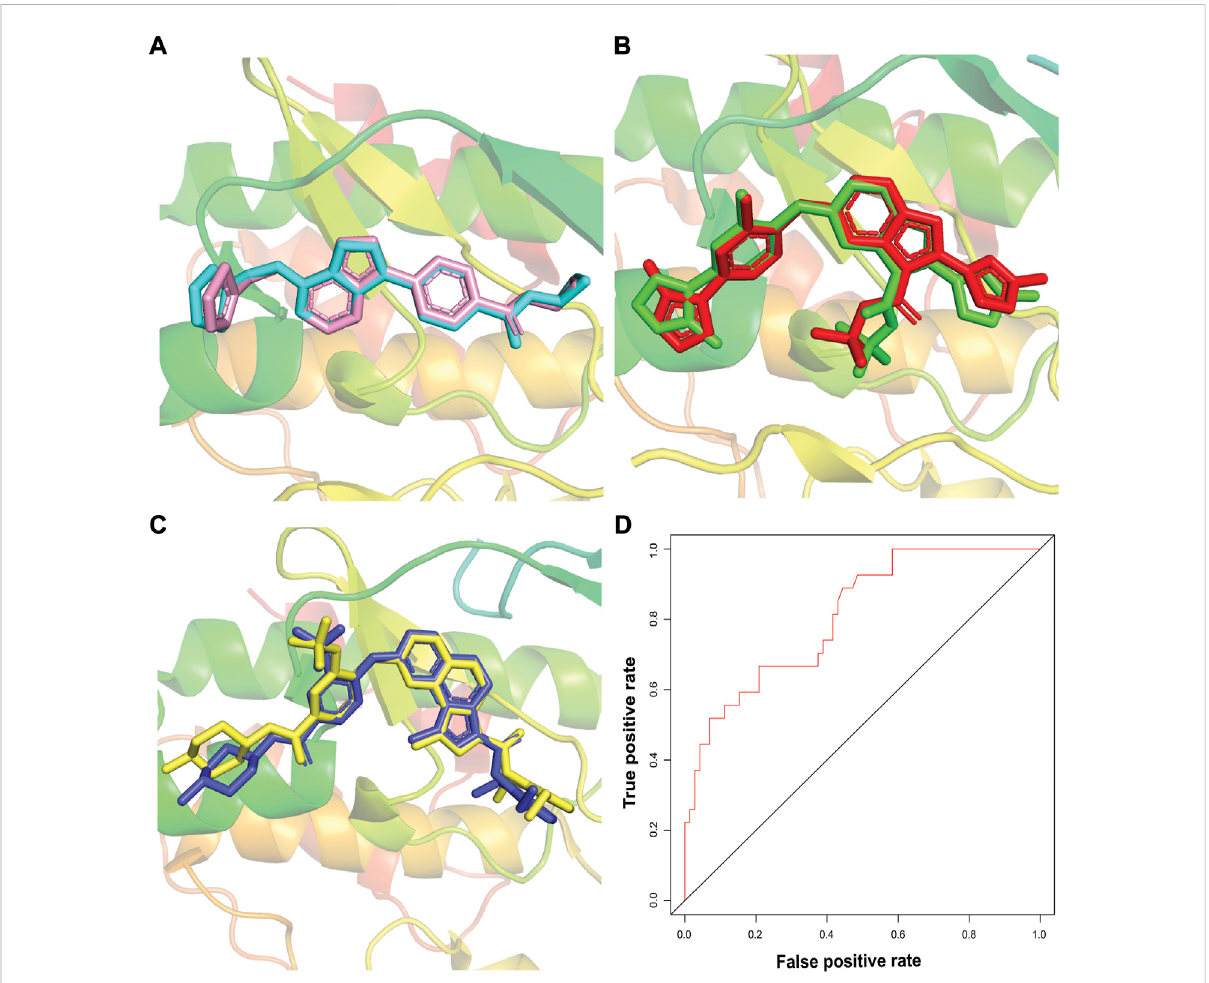
FIGURE 4 Docking protocol validation studies. The redocking ofco-crystal ligands ofthree TTK X-rays crystalstructures, (A) redocked poseof ligand in PDB ID: 3WZK is shown in cyan sticks, (B) redocked pose of ligand in PDB ID: 4C4J isshown in green sticks, (C) redocked pose of ligand in PDB ID: 5AP7 is shown in yellow sticks. The RMSD of redocked poses was less than 1Å. (D) The estimation of docking accuracy by AUC curve with a value of